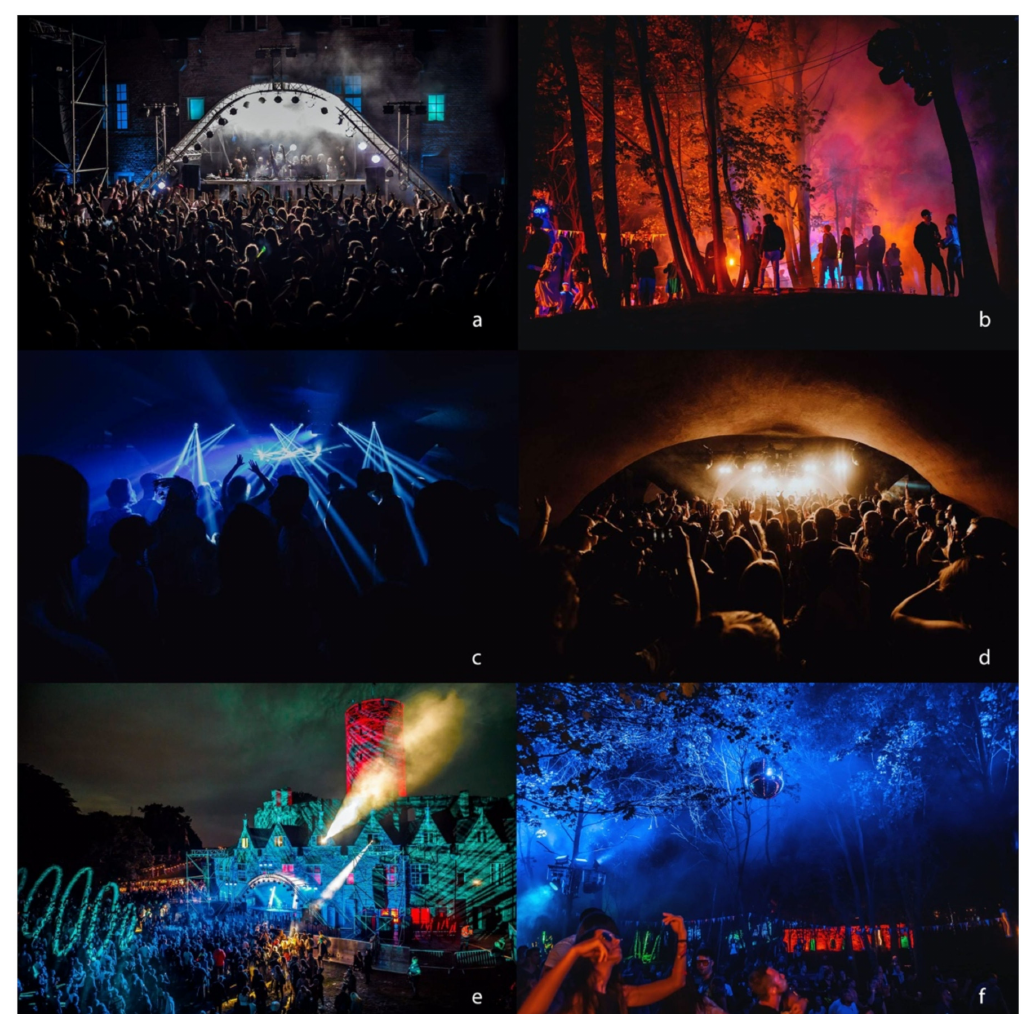
Figure 3. Images from recent events of the Wisłouj´scie Festival showcasing the extent of ALAN on Nature 2000 site. Source: ( a ) Wojtek Rojek, ( b – f ) Zuzanna